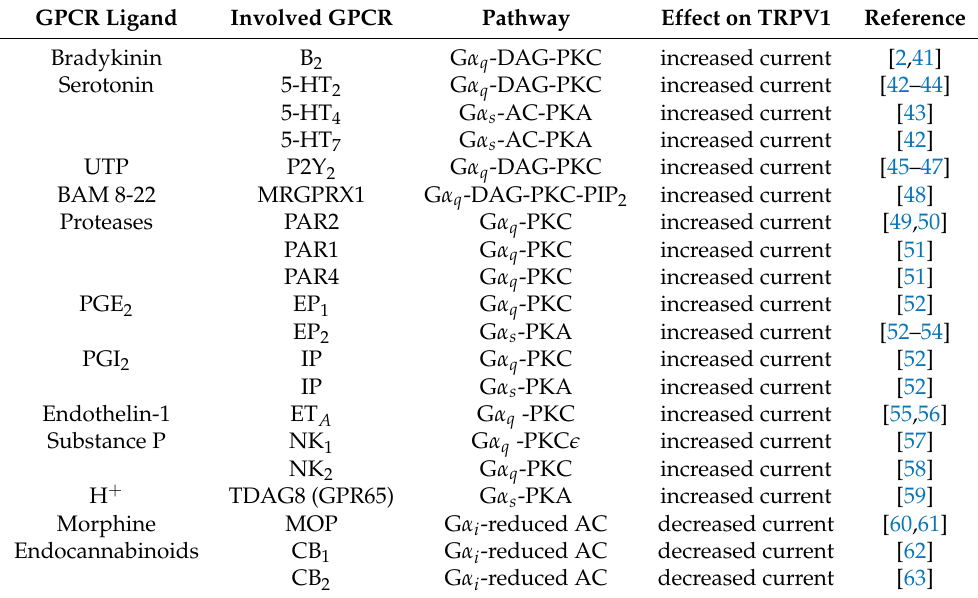
Figure 1. TRPV1 channels can be gated by different mechanisms (as indicated). Three major G-protein- dependent pathways modulate the function of TRPV1 channels. Activation of G α q /11 -coupled receptors ( left ) leads to activation of phospholipase C (PLC), which hydrolyzes phosphatitylinositol 1,4, bisphosphate (PIP 2 ) into inositiol 1,4,5 trisphosphate (IP 3 ) and diacylglycerol (DAG). DAG activates protein kinase C (PKC), which phosphorylates TRPV1 channels, thereby increasing their function. Activation of a G α s -coupled receptor ( center ) stimulates adenylyl cyclase (AC), which produces cyclic adenosine monophosphate (cAMP). Subsequent activation of protein kinase A (PKA) leads to phosphorylation of TRPV1 channels and an increase in current. Stimulation of a G α i / o -coupled receptor ( right ) decreases AC activity. Therefore, less cAMP is formed, PKA is less active and hence TRPV1 channels are not phosphorylated which decreases their activity. Table 1. GPCRs modulating TRPV1